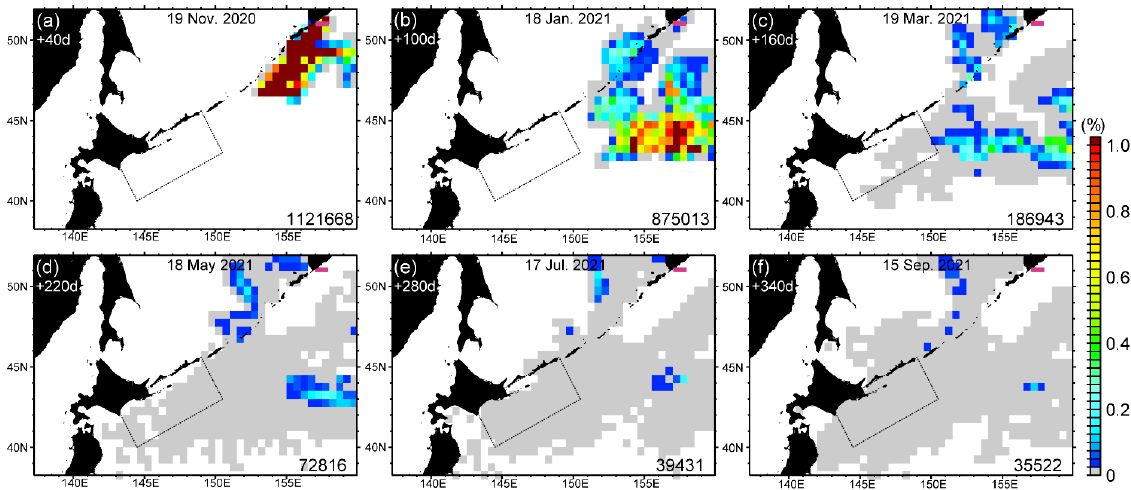
Figure 12. The same as Figure 10, but for prospective particle-tracking simulations. Elapsed time of particle tracking from the initial time is ( a ) 40, ( b ) 100, ( c ) 160, ( d ) 220, ( e ) 280, and ( f ) 340 days. The pink, thick line in the Pacific Ocean near the Kamchatka Peninsula in each panel indicates the initial position of the particles.